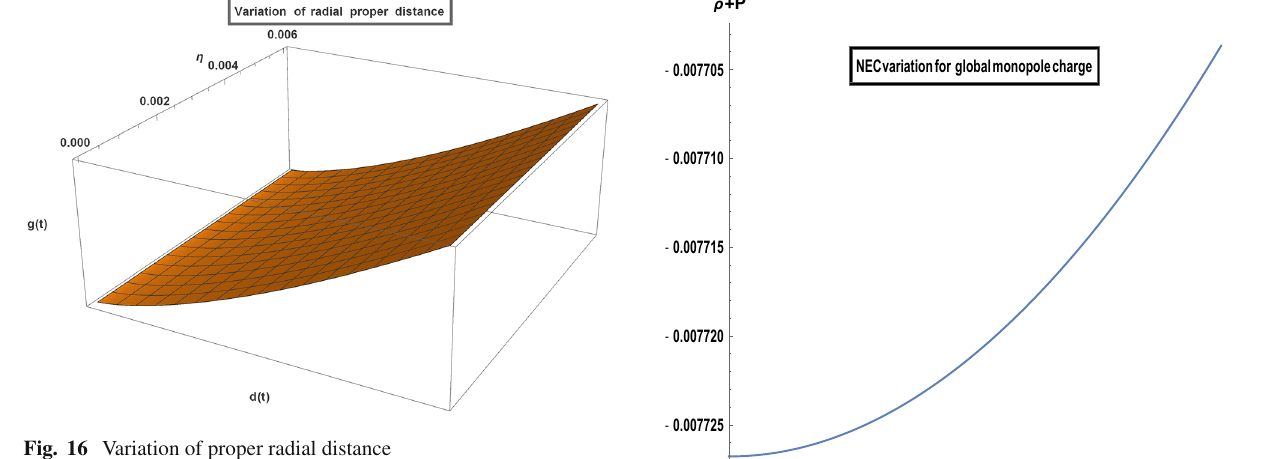
Fig. 16 Variation of proper radial distance